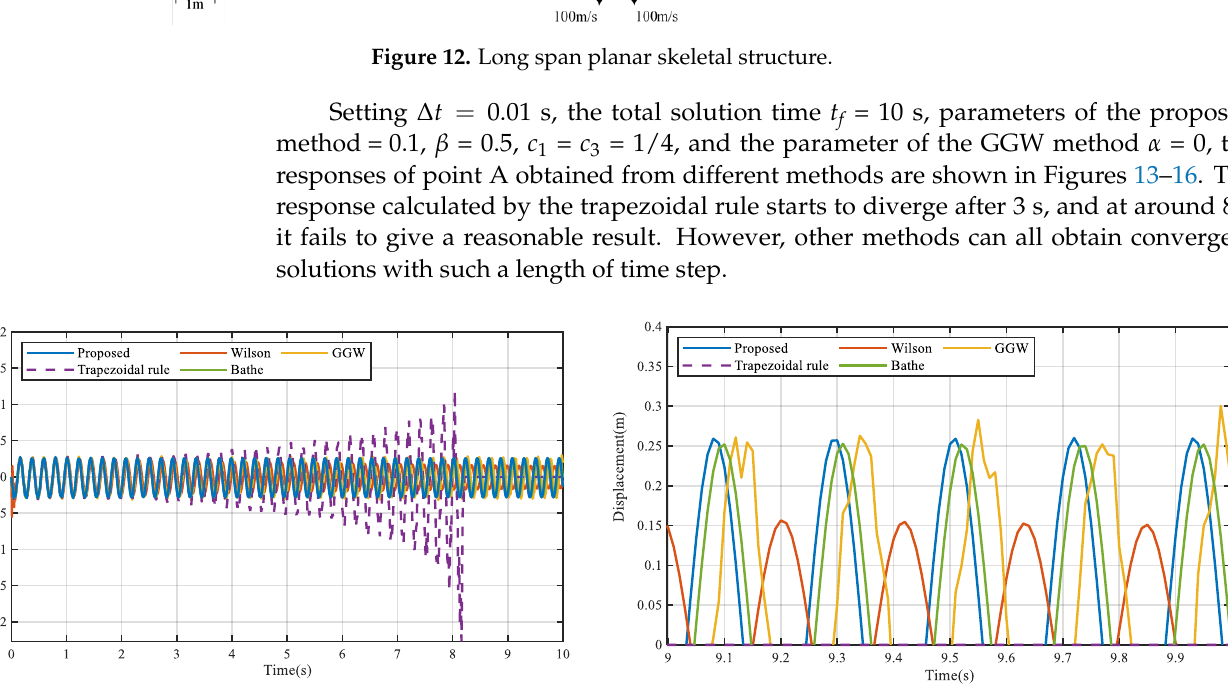
Figure 13. Displacement responses of Point A with the Wilson method, Bathe method, GGW method, trapezoidal rule, and the proposed method: ( a ) responses from 0 to 10 s; ( b ) partial enlarged drawing of responses from 9 to 10 s.